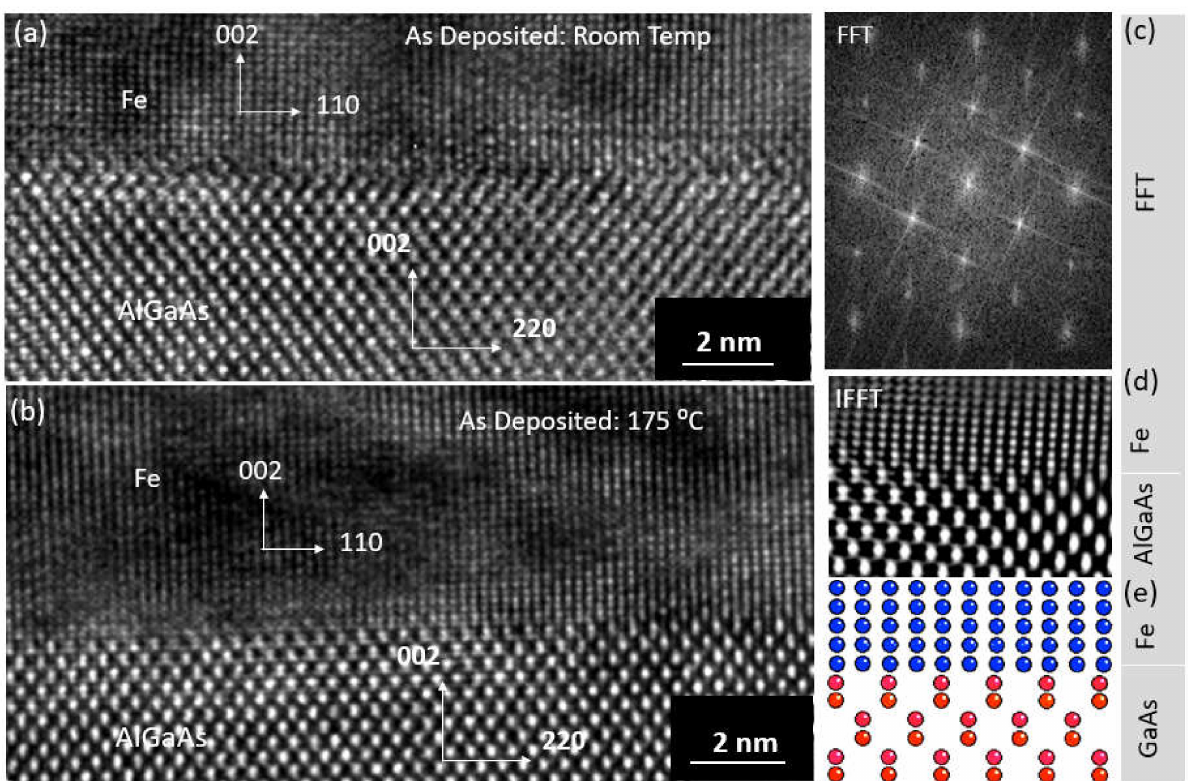
Figure 5. ( a ) A HRTEM image of the film grown at room temperature showing the structure of Fe and AlGaAs layers, and the interface close to the [011] zone of AlGaAs; ( b ) The corresponding FFT from both layers is shown as a right inset; ( c ) An HRTEM image of the film grown at 175 ◦ C, showing the structure of Fe and GaAs layers, and the interface close to the [011] zone of AlGaAs; ( d ) The IFFT image; ( e ) A schematic diagram of the Fe/GaAs interface structure in the observed orientation